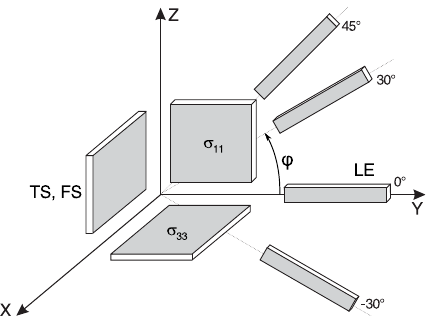
Figure 1. The crystal cuts of langasite used to determine the full set of electromechanical data (Ikeda, 1990). Four differently rotated rods with electrodes perpendicular to X axis vibrate in length ex- tensional mode (LE). The rectangular Y -cut plate vibrates in face shear (FS) and thickness shear (TS) modes. The rectangular X - and Z -cut plates are used for conductivity